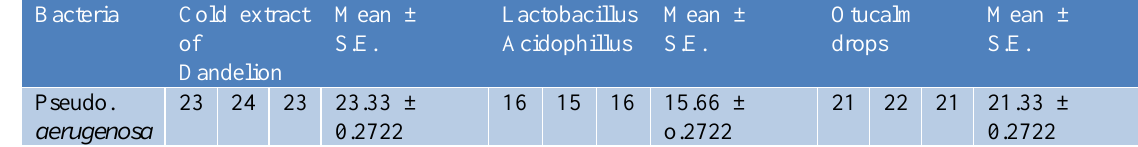
Table, 1: Show the inhibition effect of Dandelion cold alcoholic extract and Lactobacillus acidophillus, Outocalm against P. aerugenosa zon. Bacteria Pseudo. Table, 2: Inhibitory effect of some antibiotic disc against P. aerugenosa zone bacteria. Number